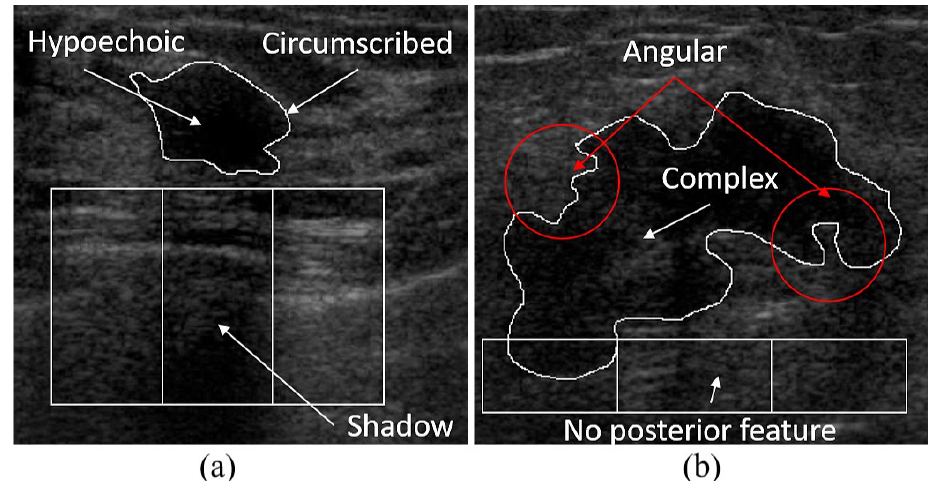
Figure 1. Illustration of BI-RADS descriptor. ( a ) Benign lesion (Category 3); ( b ) malignant tumor (Category 4).